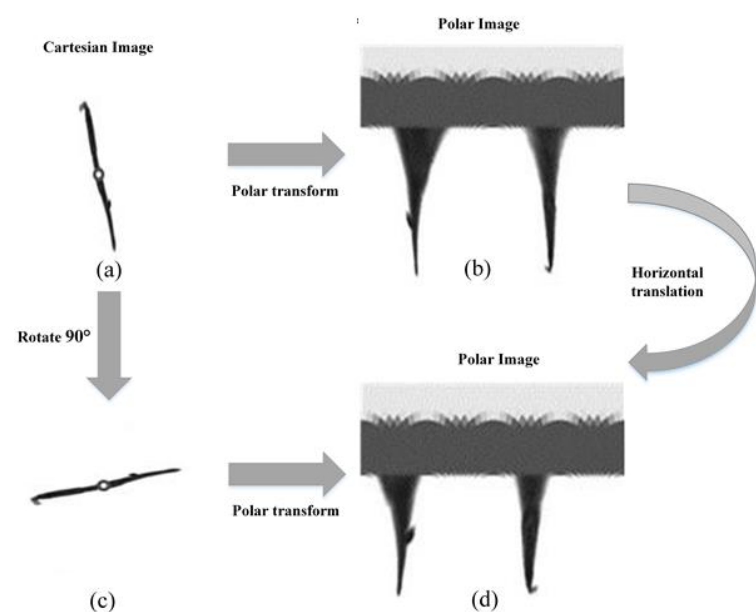
Figure 5. Description of rotational invariance. The rotation of an object can be illustrated as a type of horizontal translation. ( a ) an arrow worm (kind of plankton) image described by Cartesian coordinates; this is common and ordinary.; ( b ) description by polar coordinates; ( c ) arrow worm image in ( a ) was rotated 90 ◦ clockwise; ( d ) description by polar coordinates.